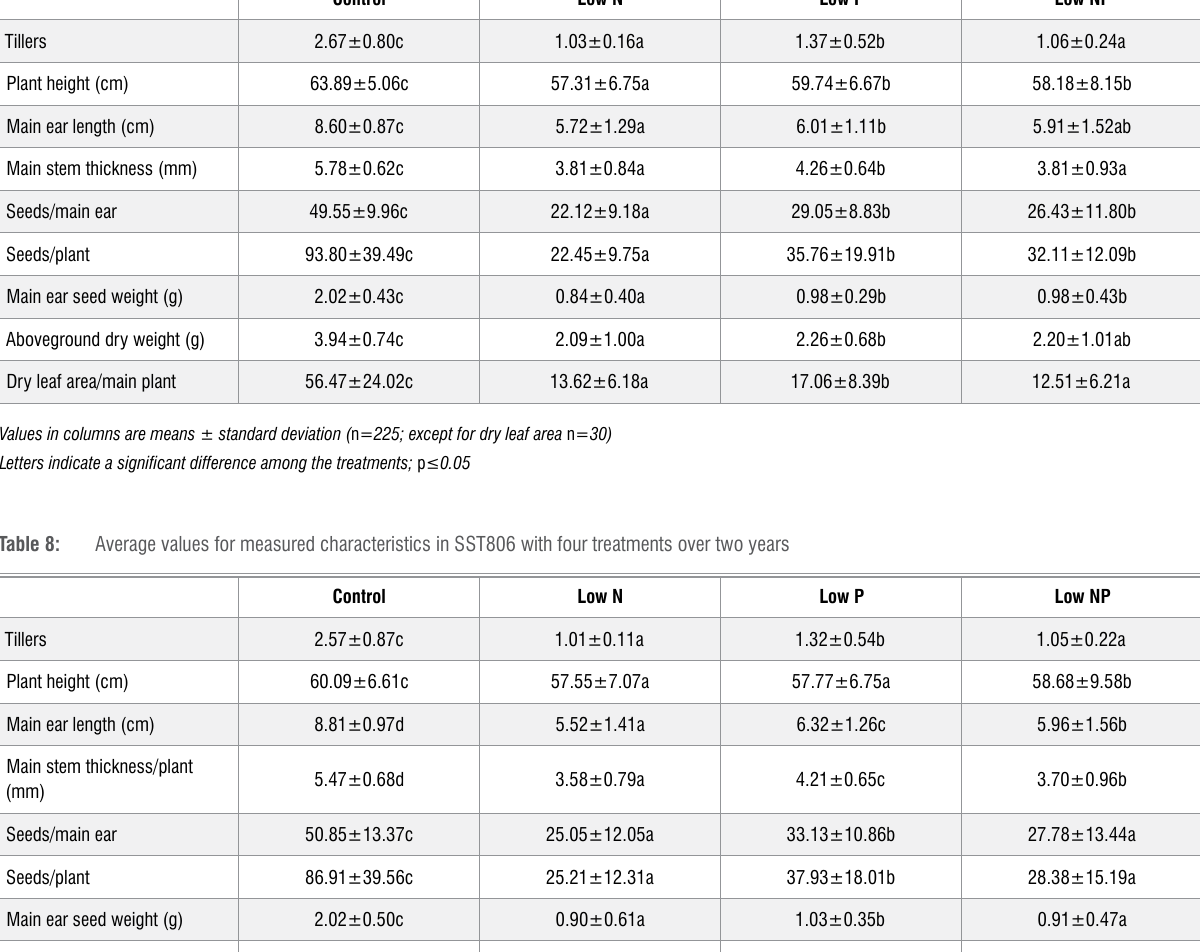
Table 7: Average values for measured characteristics in PAN3479 with four treatments over two years Control